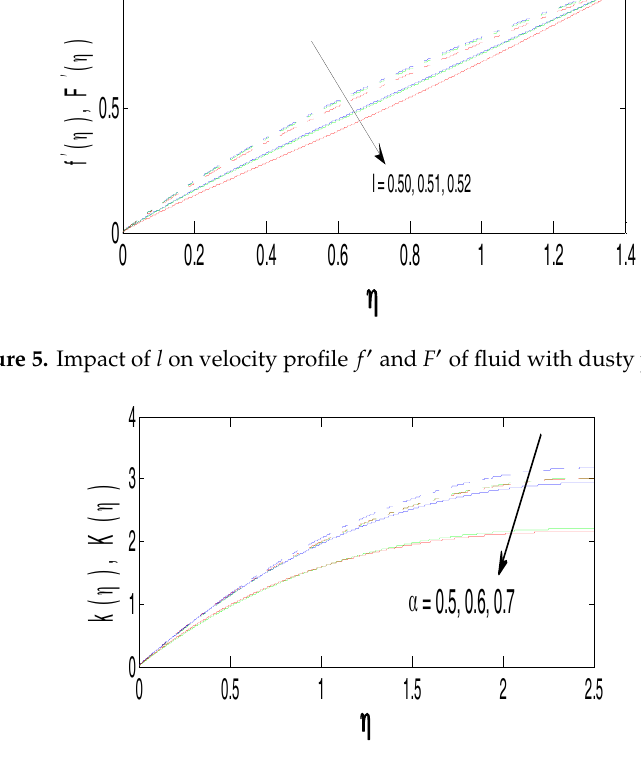
Figure 6. Impact of α on draining velocity k and K of fluid with dusty particles.